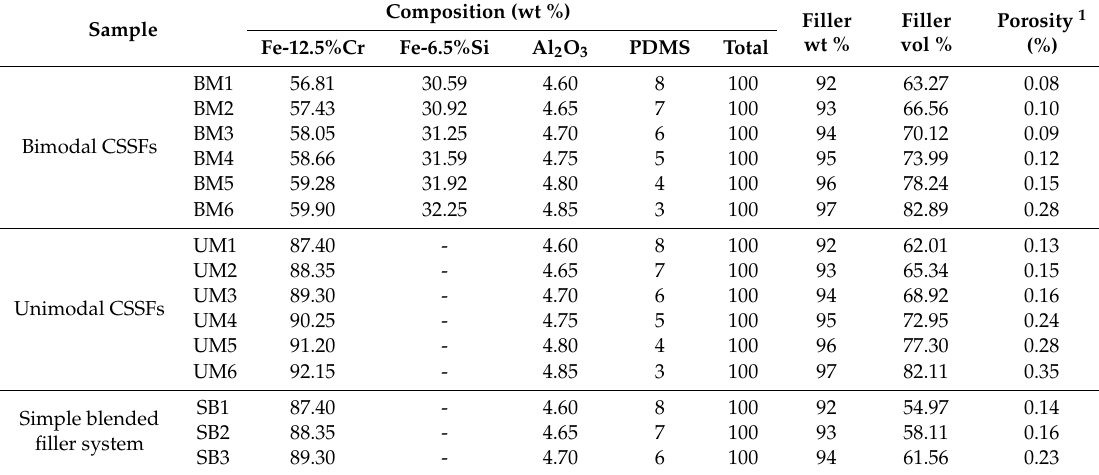
Table 1. Compositions of three kinds of dual-functional sheets (DFSs) and their porosity values. PDMS: Polydimethylsiloxane.